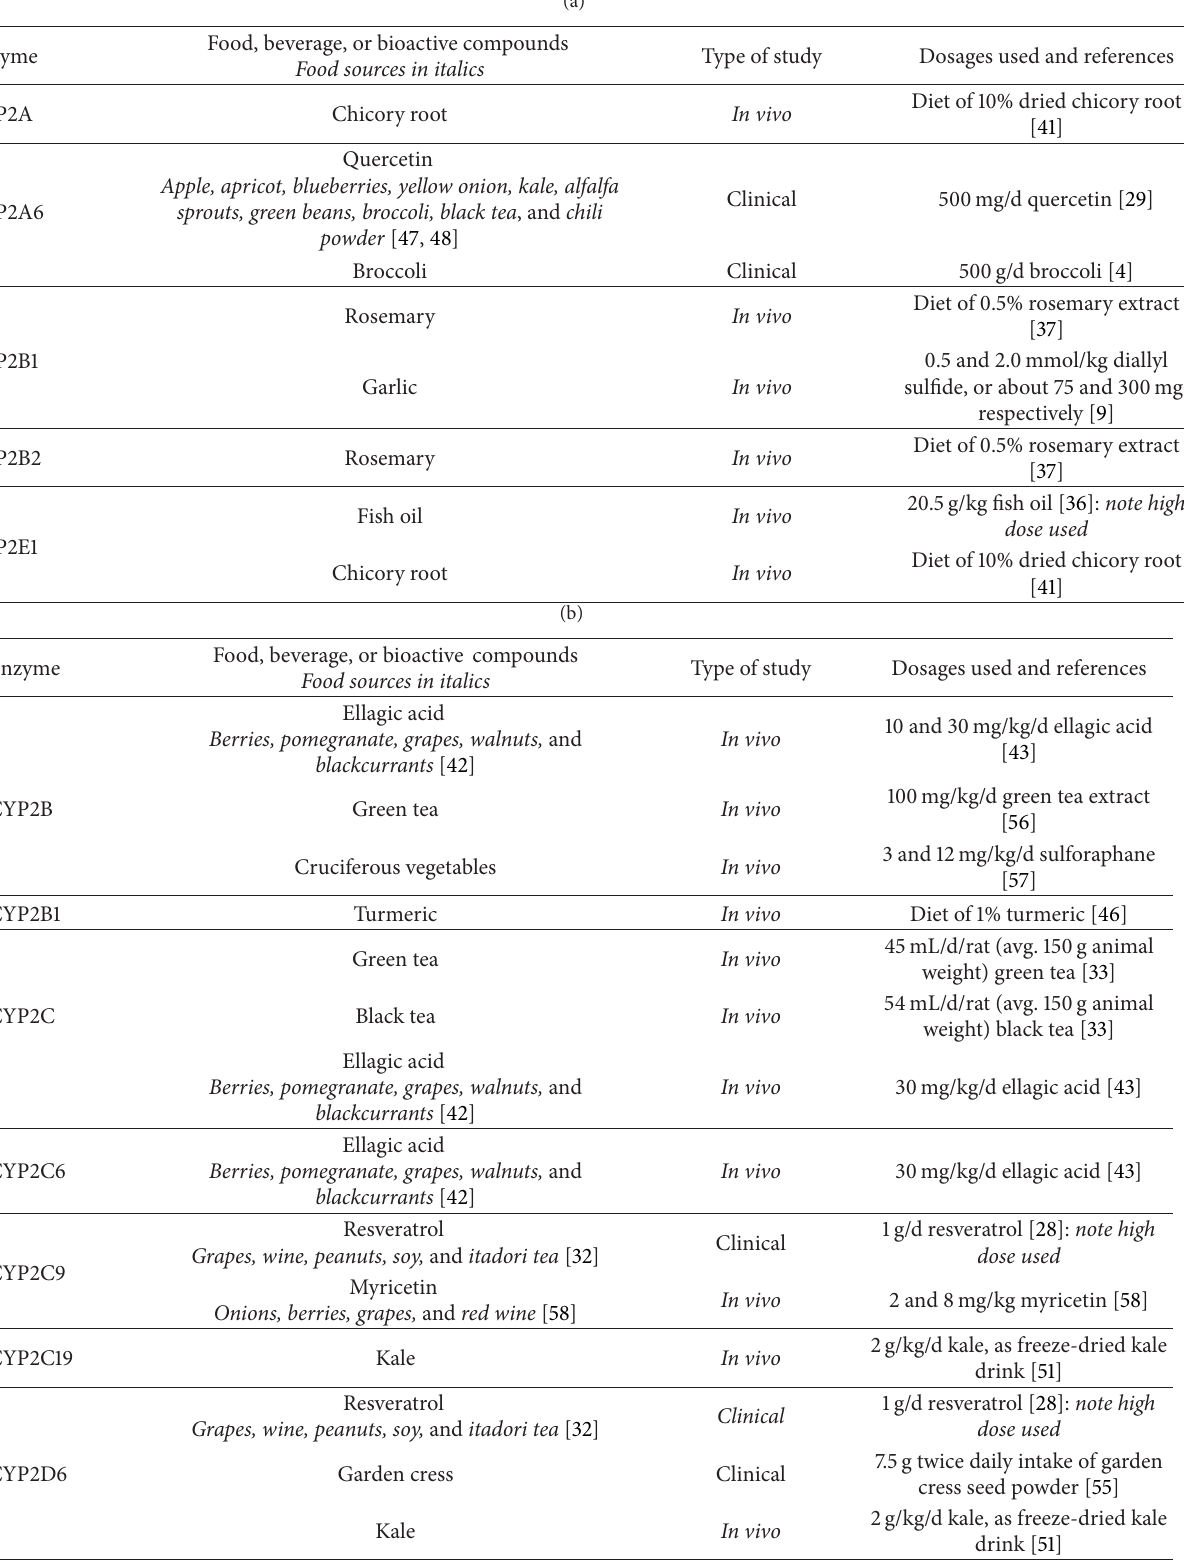
Table 2: (a) Human and in vivo example nutrient inducers of selected CYP2 enzymes. (b) Human and in vivo example nutrient inhibitors of selected CYP2